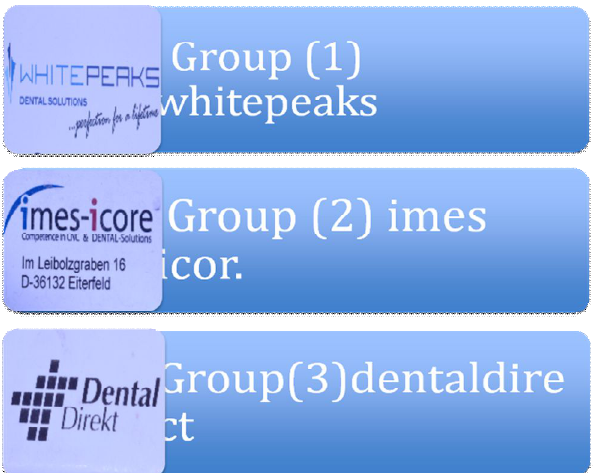
Figure 9: Groups distribution of translucent zirconia